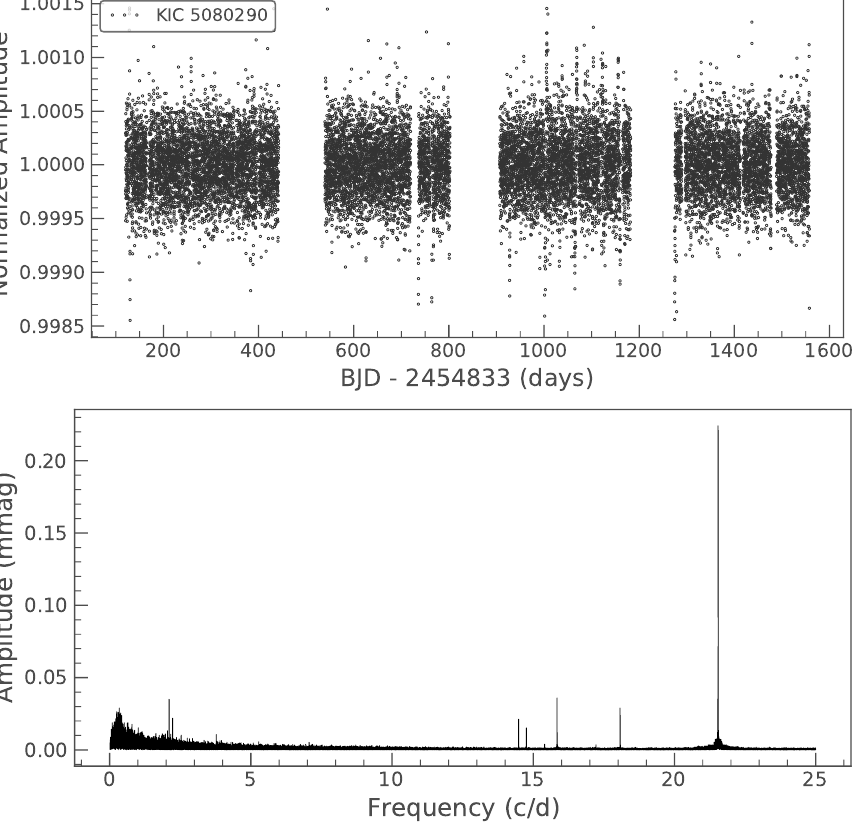
Figure 2. Normalized detrended light curve ( top ) and frequency spectrum ( bottom ) of KIC